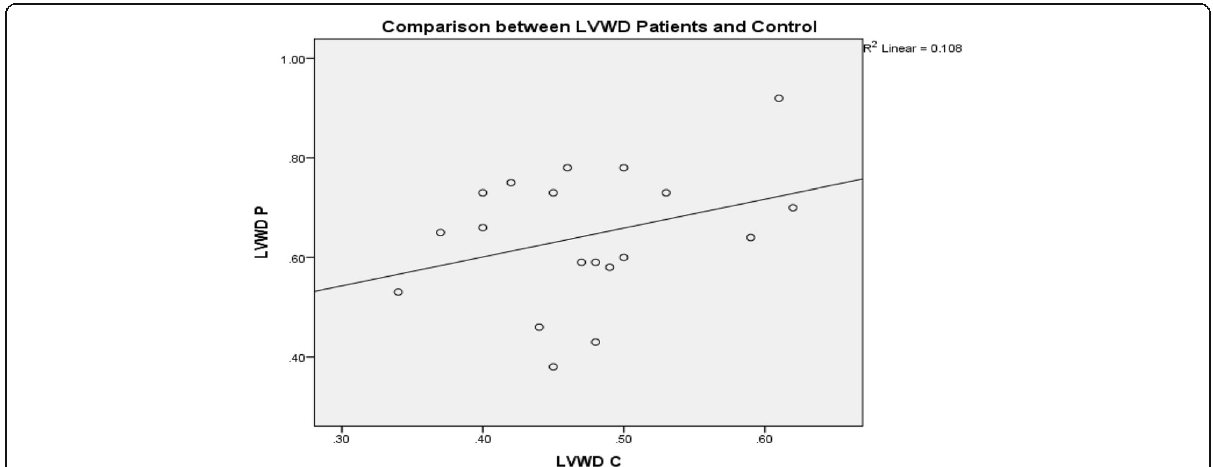
Fig. 3 Linear regression curve to illustrate significant correlation between LVWT for both patients and controls (correlation coefficient R 2 = 0.32)